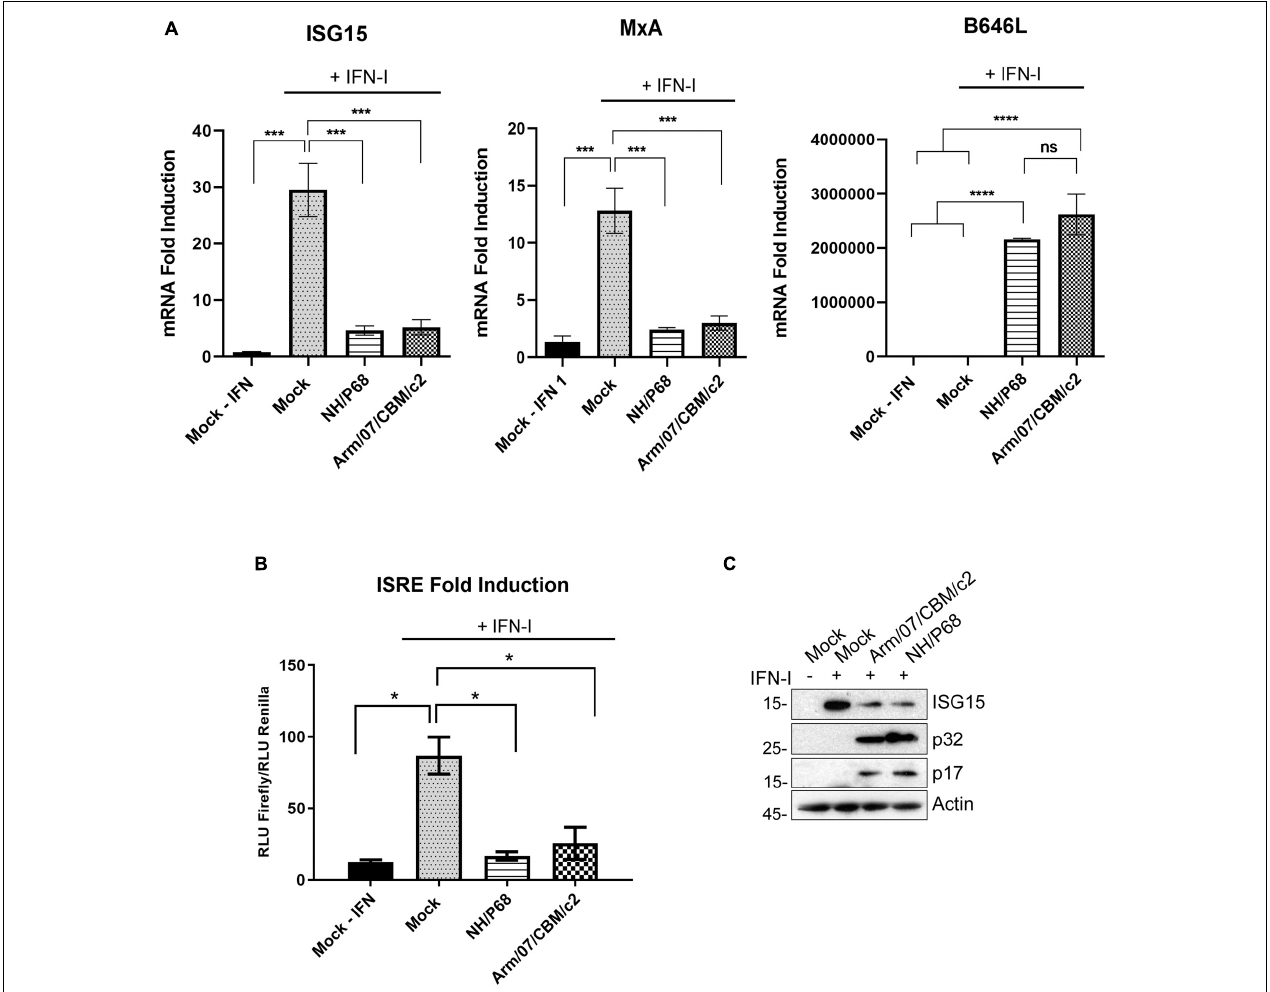
FIGURE 1 | NH/P68 and Arm/07/CBM/c2 ASFV strains are able to impair IFN-I signaling. PAMs were either mock infected or infected with NH/P68 or Arm/07/CBM/c2 ASFV strains (1 PFU/cell). At 16 h post-infection, cells were mock treated or treated with universal type I IFN (1,000 U/ml) for 8 h. ISG15 and MxA mRNAs were measured by qRT-PCR (A) . As a control of infection, ASFV viral B646L gene mRNA was determined. The obtained values were relativized against the mock infected and untreated sample. All data are means ± SEM ( n = 3). One-way ANOVA statistical analysis and Tukey’s multiple comparison test were performed (* p < 0.05, *** p < 0,001; **** p < 0,0001). ISRE-luciferase reporter assay in mock infected or infected COS-1 cells with either NH/P68 or Arm/07/CBM/c2 strains (1 PFU/cell, 16hpi) treated or not with type I IFN (1,000 U/ml) (B). Graphs represent the means of the Firefly luciferase RLU (Relative Luminiscence Units) values divided by its Renilla luciferase RLU values from biological triplicates. The obtained values were relativized against the mock infected and untreated sample. Two-tailed t -test comparison made with Mock + IFN (* p < 0.05). Western blot analysis of ISG15, viral p17, p32 and actin expression in COS-1 cells lysates previously used for the luciferase assay (C)